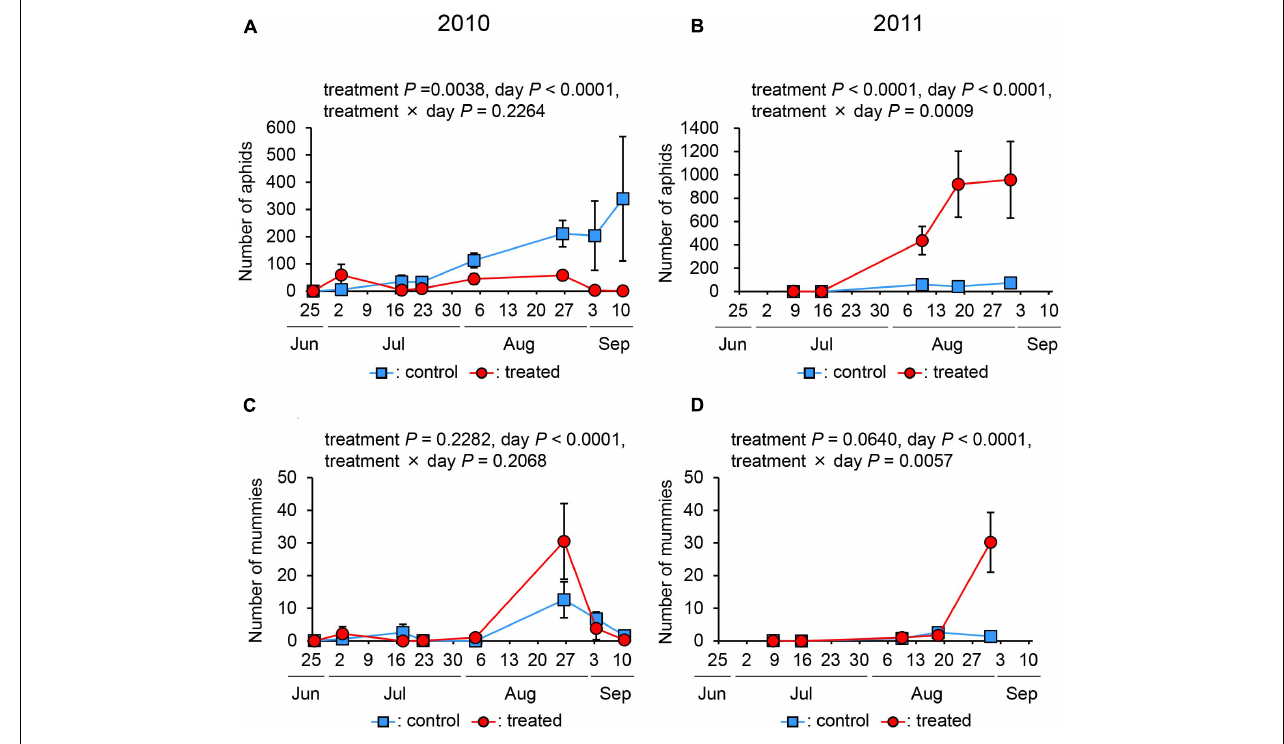
FIGURE 3 | The number of aphids (A,B) and parasitised aphids (mummies) (C,D) in treated and control plots in 2010 and 2011.